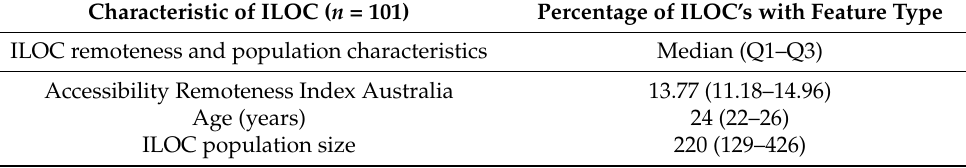
Table 1. Cont. Characteristic of ILOC ( n = 101) Percentage of ILOC’s with Feature Type ILOC remoteness and population